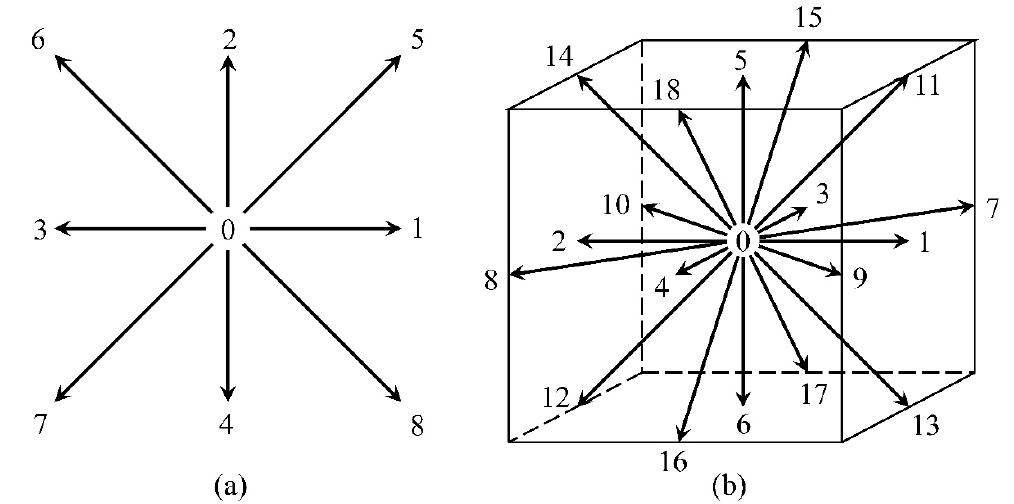
Figure 1. The D2Q9 ( a ) and D3Q19 ( b ) lattice speed model.